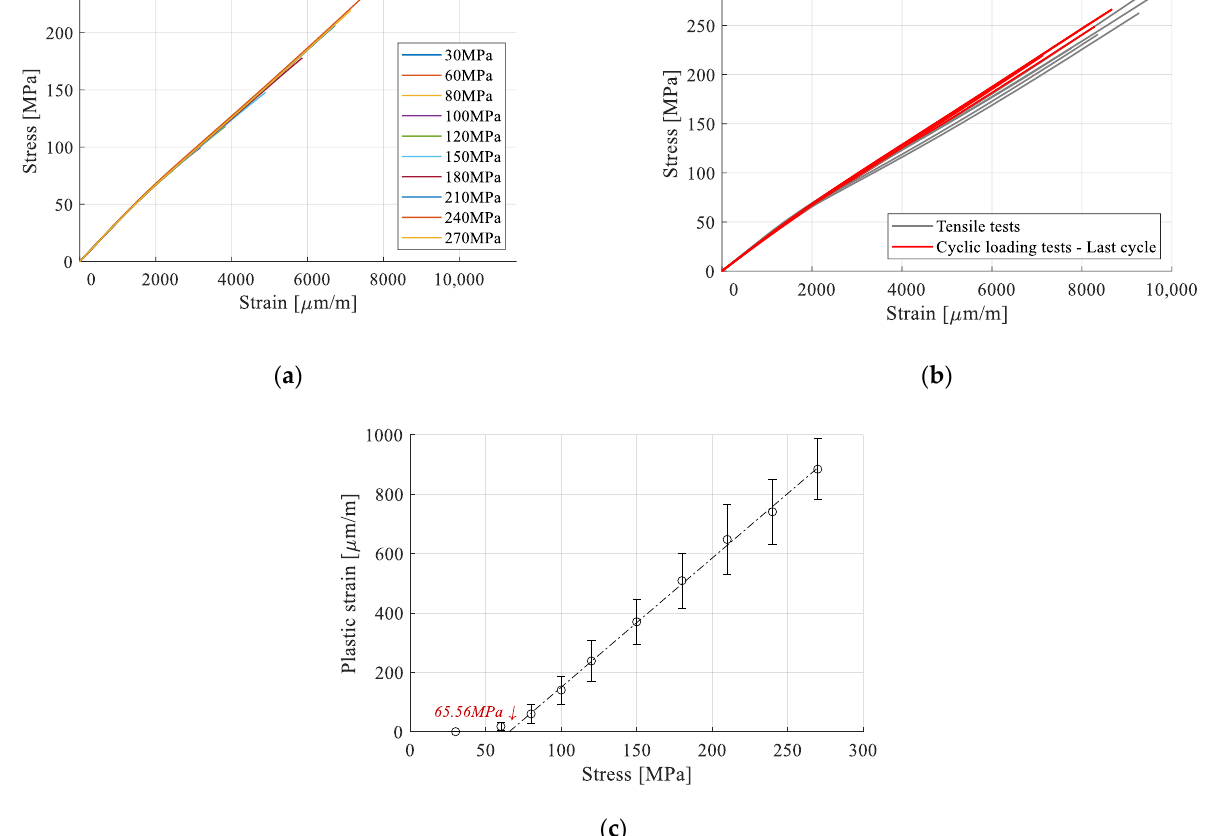
Figure 11. Analysis of the strain response: ( a ) loading phases in stress–strain coordinates; ( b ) com- parison of stress–strain curves between fresh samples and those subjected to multiple stress levels; ( c ) plastic strain with respect to cycle stress level.